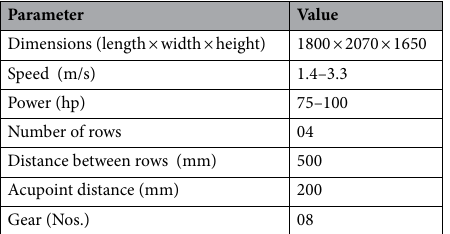
Table 1. Main parameters of the planter with inclined seed-metering device.